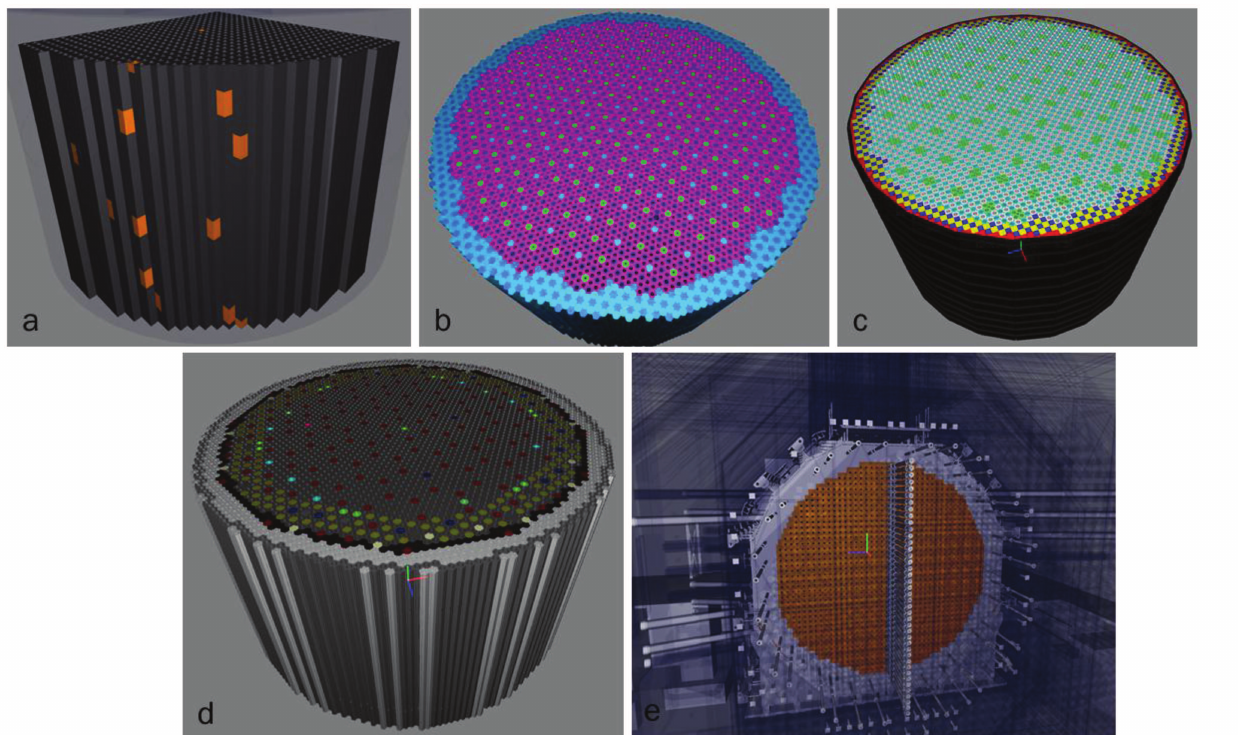
Fig. 2. Graphite core reactor 3D models integrated on DEMplus R (cid:13) . (a) Ignalina, (b) Vandellos I, (c) Latina, (d) Chinon A2, (e) G1.